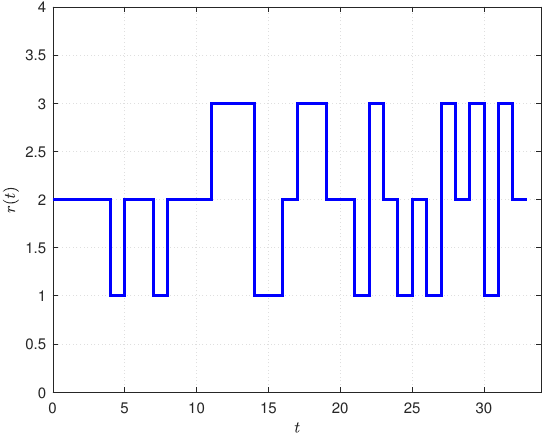
Figure 8. Semi-Markov switching signal with three